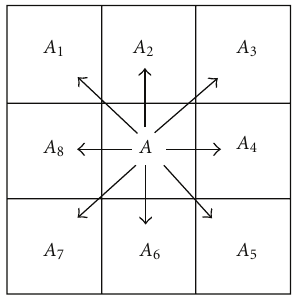
Figure 3: The implementation of homogeneity